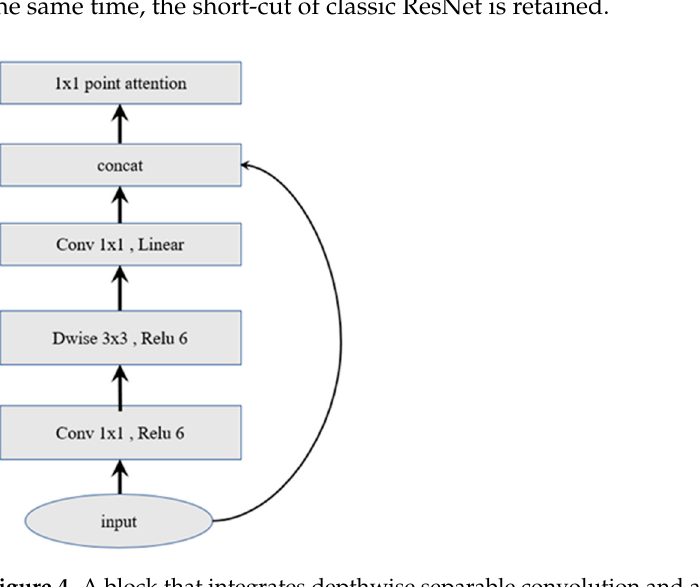
Figure 4. A block that integrates depthwise separable convolution and attention mechanisms.